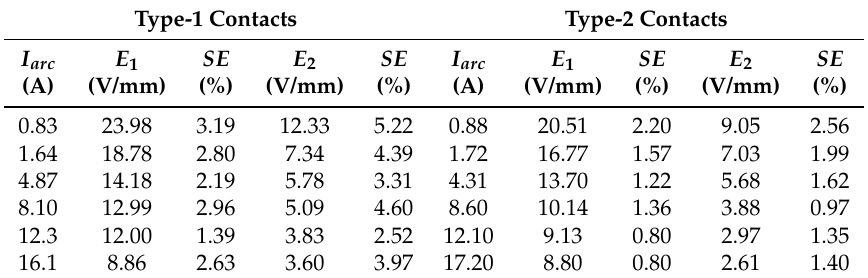
Table 2. Electric field fit values according to (4) for both cases at various